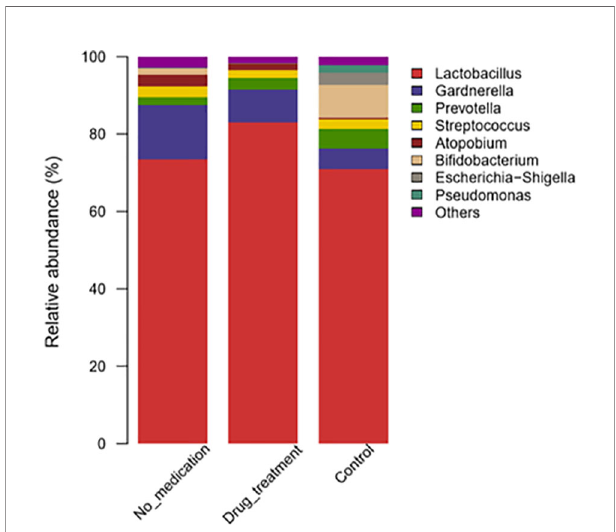
FIGURE 2 | Taxonomic classi fi cation of the vaginal microbiota at the genus level among different